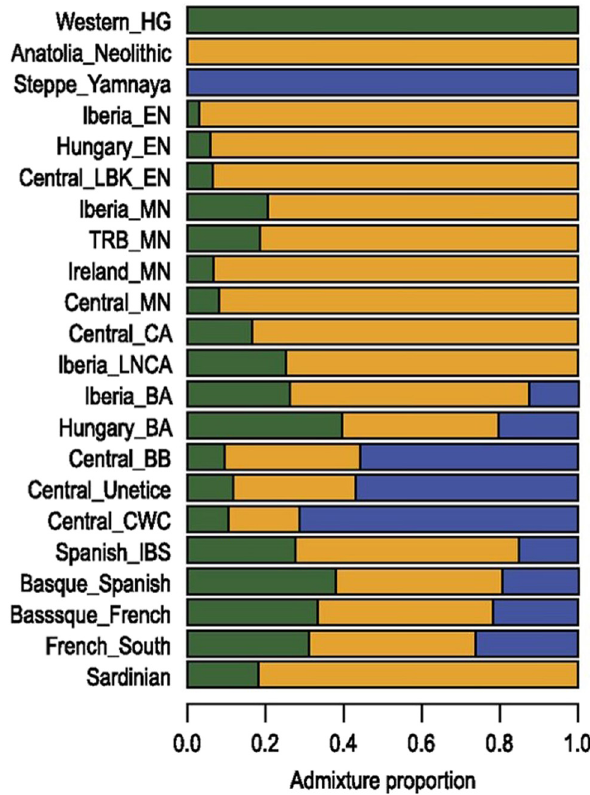
Figure 4: Genetic admixture between hunter - gatherers and Neolithic groups after Valdiosera et al. ( 2018 ) . Unlike the diversity observed in material culture ( Figure 2 ) , genetic analysis points to low variability within groups. Iberia ’ s Early Neolithic com - munities present a considerably small amount of genetic information from previous hunter -